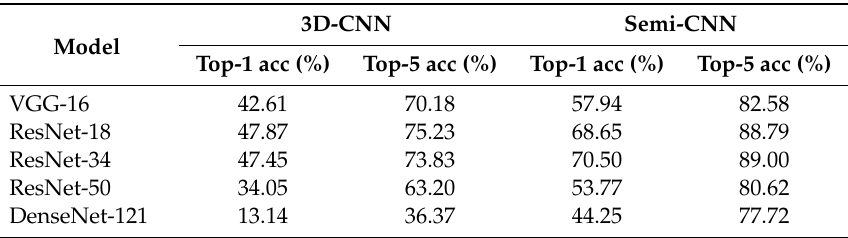
Table 4. Comparison of validation results for discontinued motion input trained on 3D-CNN and semi-CNN